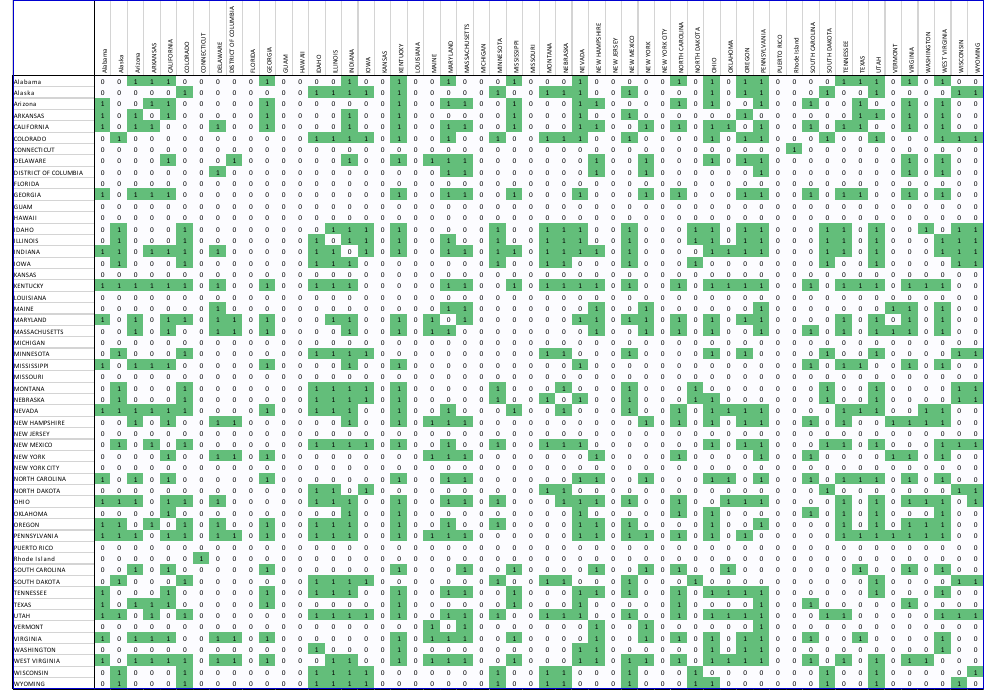
Figure 3. The US COVID-19 binary matrix. The green color represents a strong correlation between the different regions. All strong correlations are represented by 1.